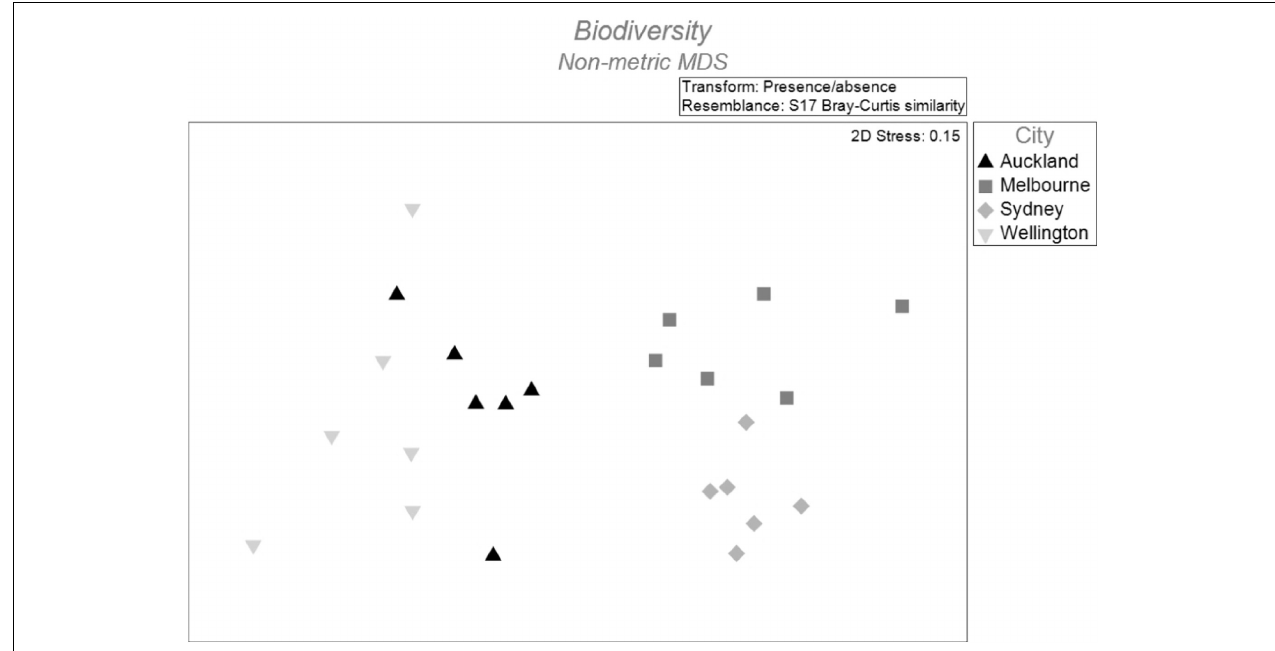
FIGURE 2 | Non-metric multi-dimensional scaling (nMDS) ordinations based on Bray–Curtis similarities of parks based on differences in total biodiversity.